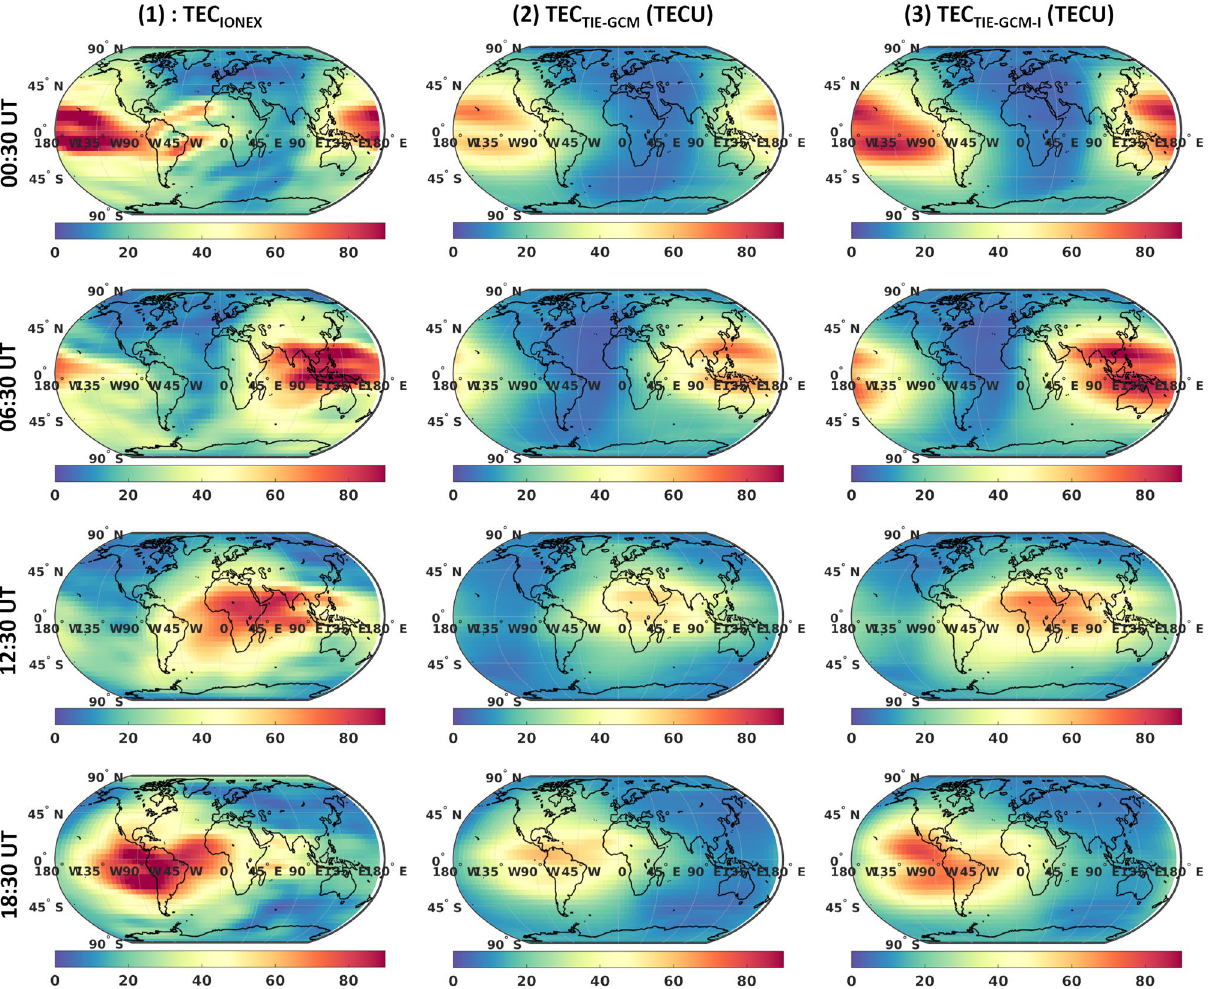
Figure 12. The 1st, 2nd, and 3rd columns present the TEC estimated derived from the IONEX final products, TIE-GCM, and TIE-GCM-I, during February 8th, 2015, respectively. MATLAB (version R2021a, https:// www. mathw orks. com/) was been used to generate these plots.